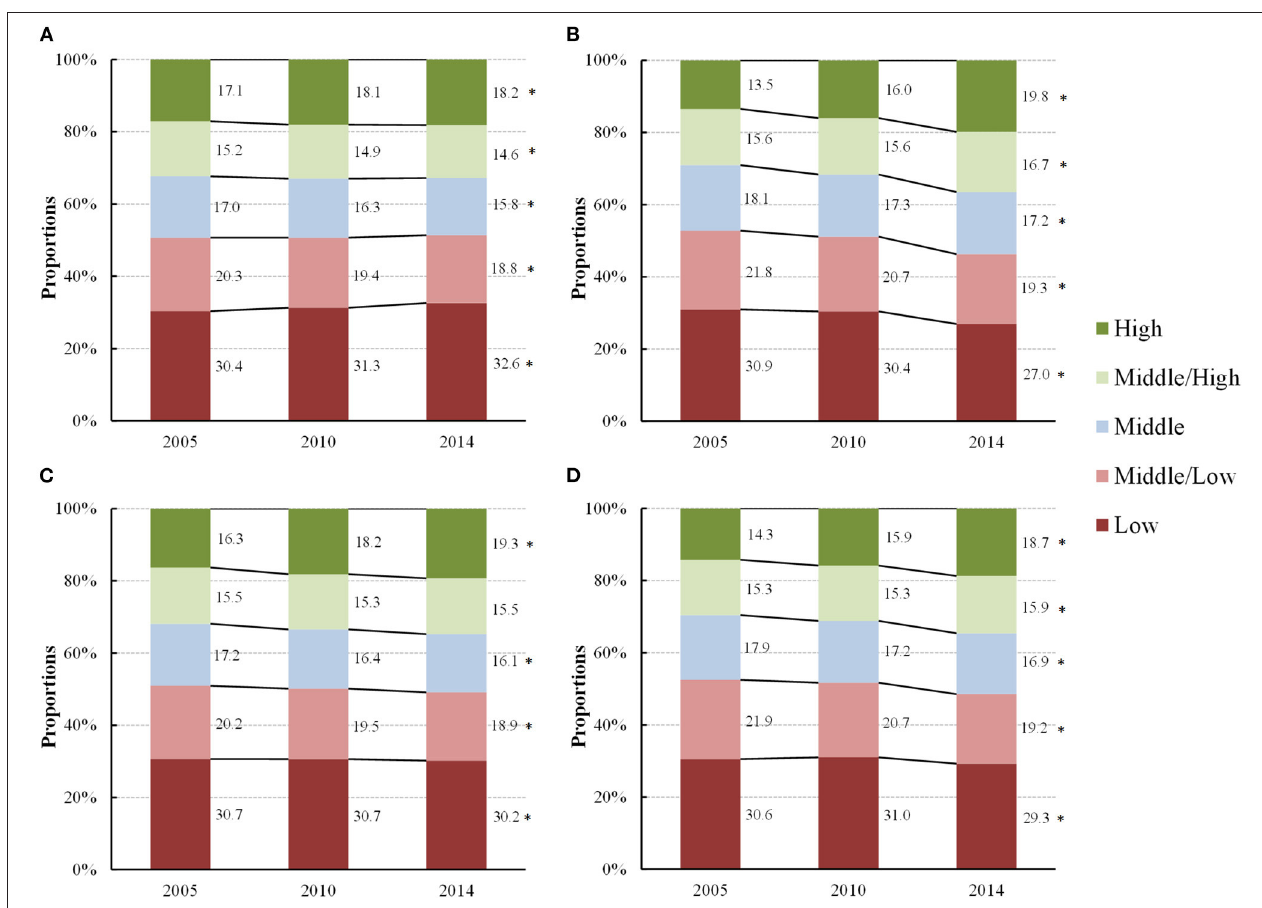
FIGURE 1 | Proportions of change in different levels of physical fitness, as indexed by physical fitness index, in children and adolescents by sex and residence [ (A) Boys, (B) Girls, (C) Urban and (D) Rural] from 2005 to 2014 (2005–2014, China). * A statistically significant increased trend or decreased trend in the proportions of each level of physical fitness from 2005 to 2014 ( P trend < 0.05) using Cochran-Armitage trend